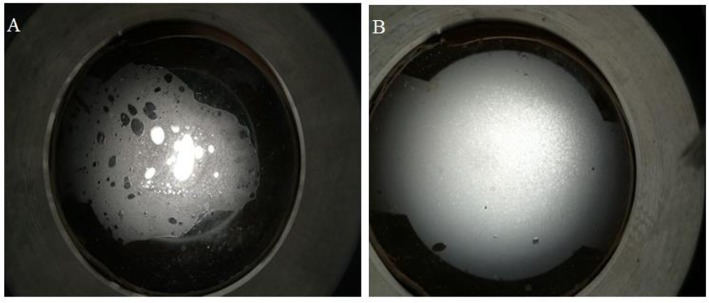
Digital photographs of SC-CO2 foams stabilized by 0.05% HHSB surfactant (A) and 0.05%+0.5% NPs (B) at 70°C and 8 MPa.